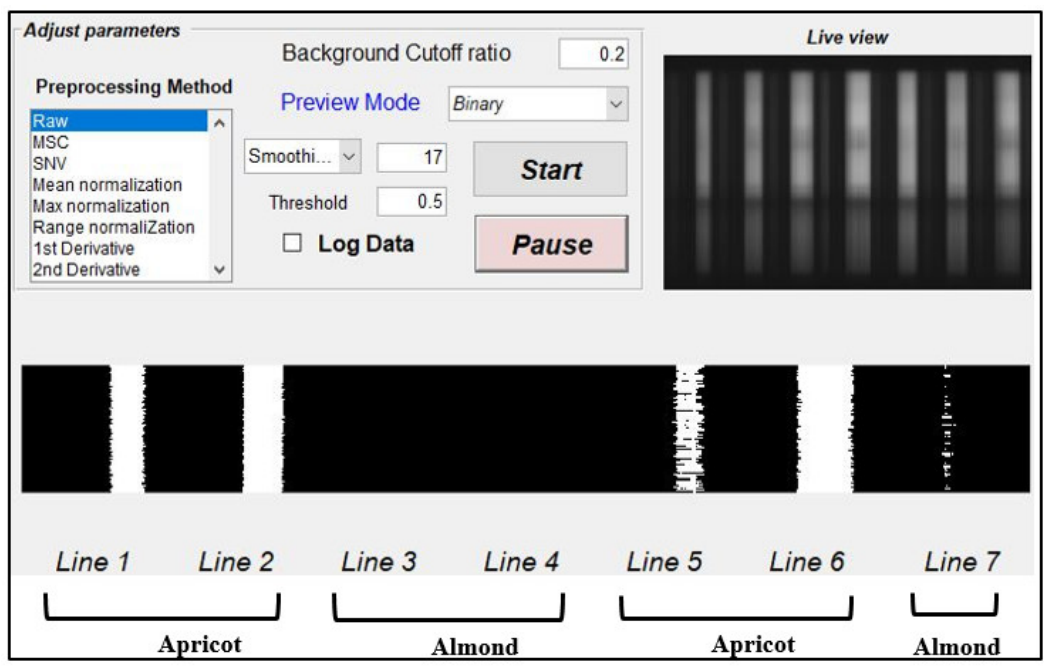
Figure 11. The moving seeds on the conveyor belt after the optimized threshold (0.5) was used to distinguish between the almonds and apricot kernels. Appl. Sci. 2020 , 10 , x FOR PEER REVIEW